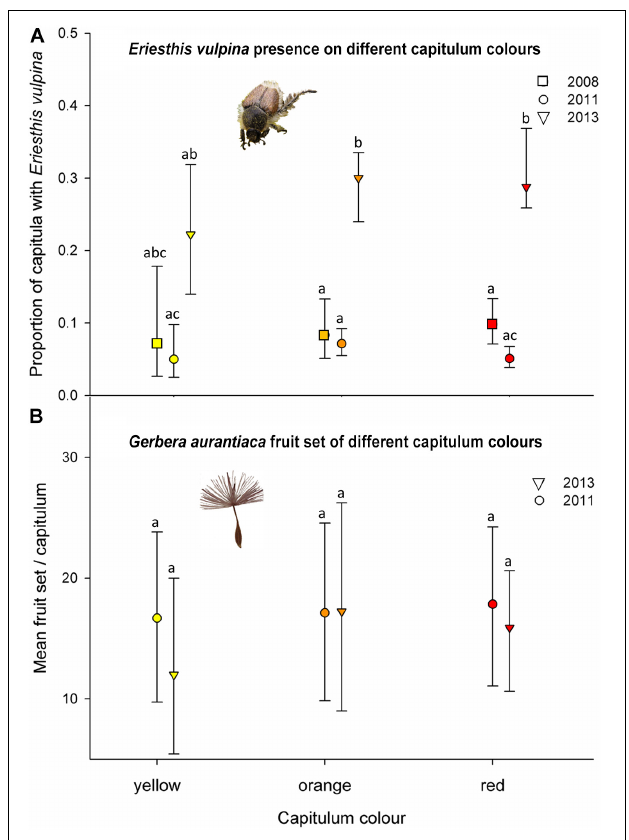
FIGURE 7 | (A) In-situ hopliine scarab beetle ( Eriesthis vulpina ) capitulum color preference in the color polymorphic RH population: Proportion of yellow, orange and red Gerbera aurantiaca capitula with E. vulpina individuals present during 2008, 2011, and 2013 flowering seasons. (B) Mean fruit set per capitulum of the yellow, orange and red color forms at the RH population in 2011 and 2013. Vertical bars indicate 95% confidence intervals. Means sharing letters are not significantly